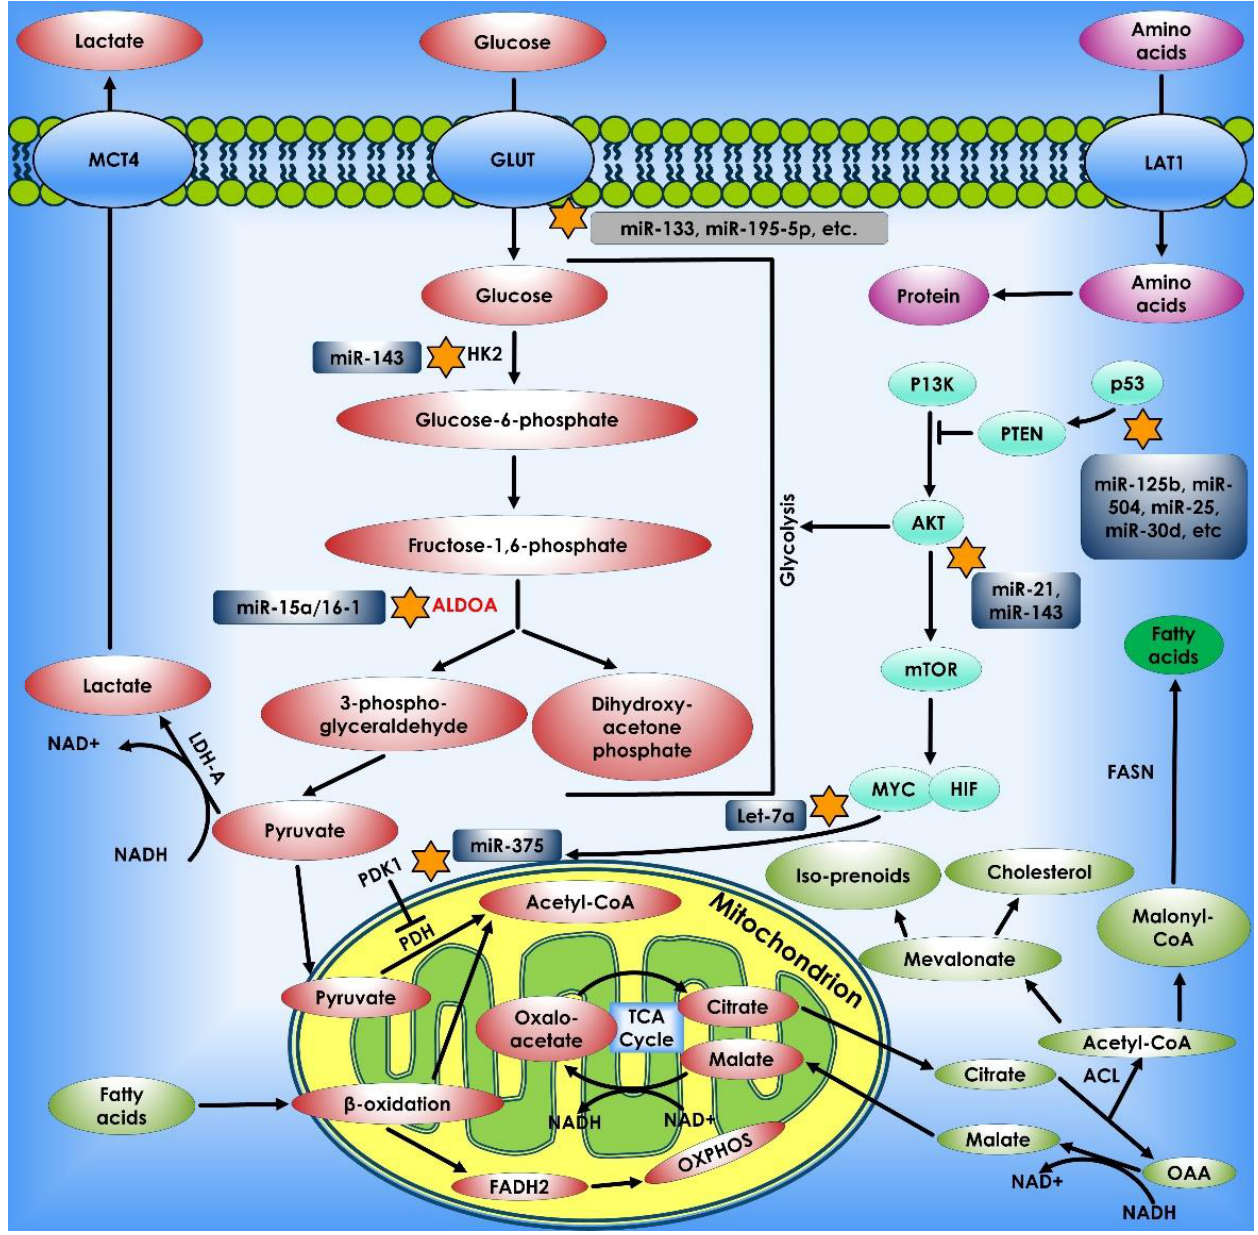
Figure 5. miRNAs and Cancer Metabolism. miRNAs control cell metabolism by targeting critical metabolic enzymes and oncogenic signaling pathways. miRNAs (shown in the dark blue shaded boxes) potentially influence cell metabolism via altering the expression of metabolic transporters (such as GLUT) or enzymes (such as HK2, ALDOA, and PDK1), as well as by acting on the p53, c-Myc , and AKT/mTOR signaling pathways.